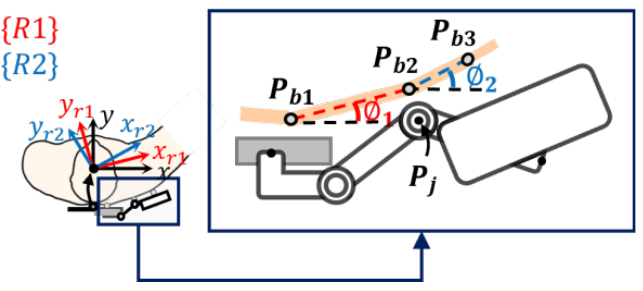
Figure 6. Parameters pertaining to interference with the human body.